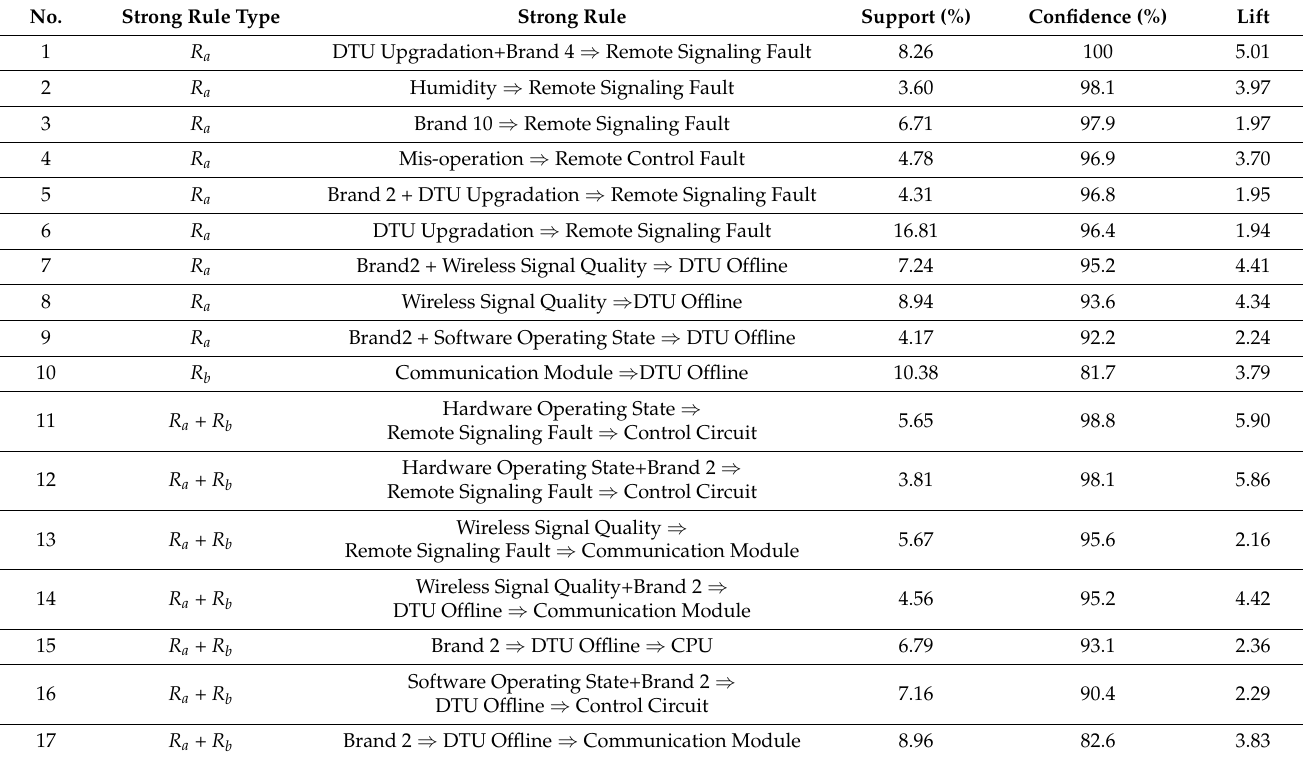
Table 5. Strong rules obtained from DTU fault database.